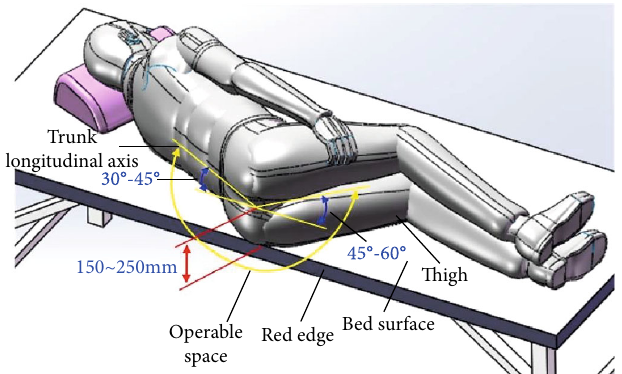
Figure 3: Operational space.